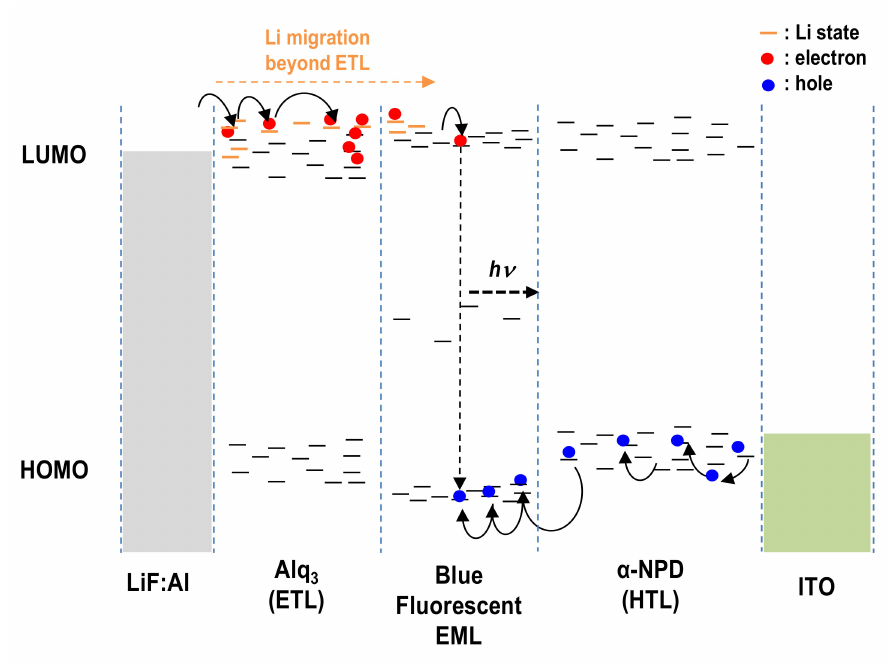
Figure 10. Schematic diagram of excessive Li ion migration in the device, quenching the exciton formation after 96 h of electrical